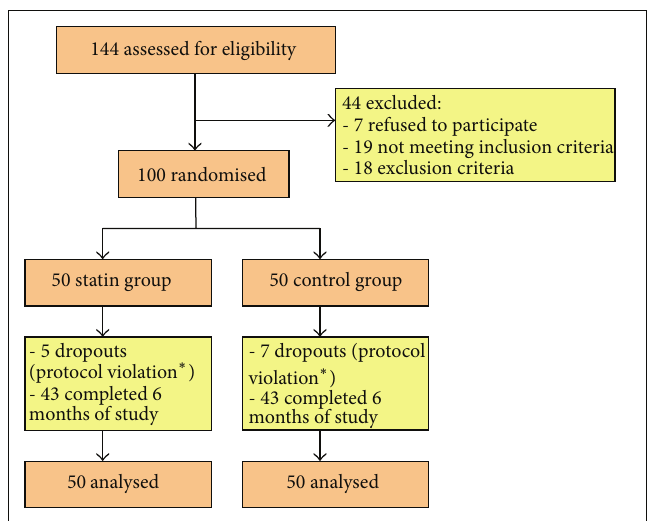
Figure 1: Study profile; ∗ modification of